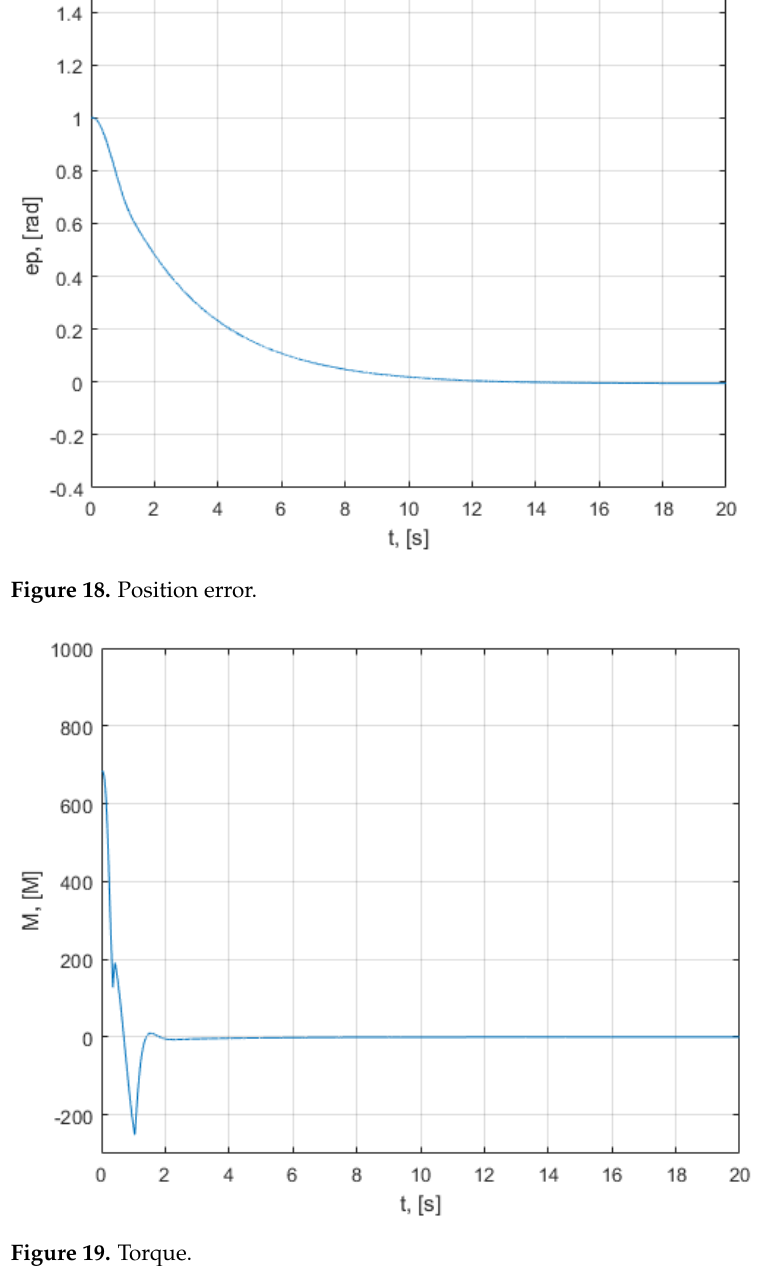
Figure 20. Speed.